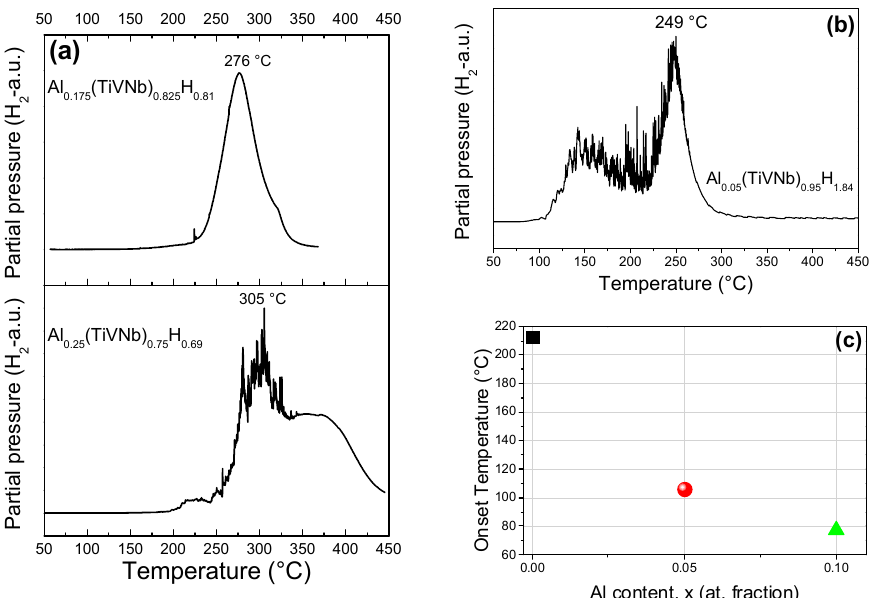
Figure 6. TDS profiles for ( a ) Al 0.175 (TiVNb) 0.825 H 0.81 ( top ) and Al 0.25 (TiVNb) 0.75 H 0.69 ( bottom ), ( b ) Al 0.05 (TiVNb) 0.95 H 1.84 , ( c ) variation in the desorption onset temperature as a function of Al content for Al x (TiVNb) 1 − x with x = 0, 0.05 and 0.10.